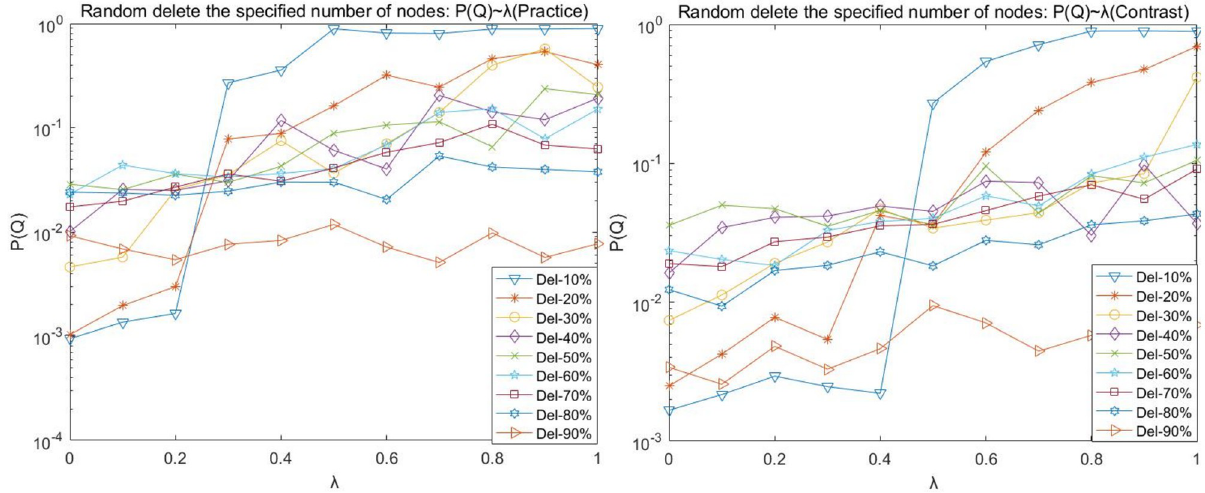
Fig 4. Random disruption- P ( Q ) with λ variation diagram.